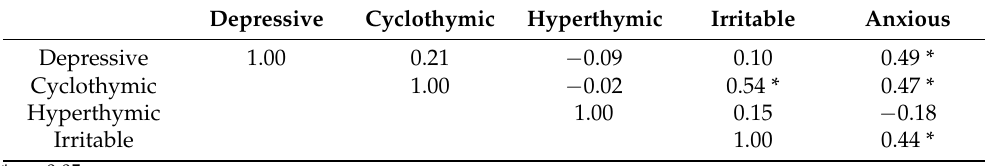
Table 1. Internal correlation between affective temperaments of TEMPS—A in the study group N = 71. Depressive